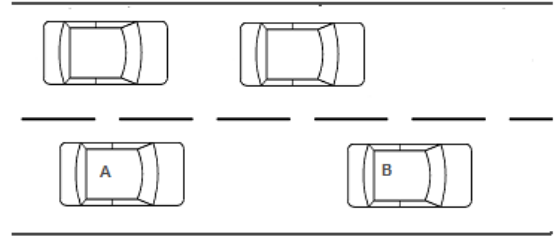
Fig.2. Driver’s car-following behavior with various traffic